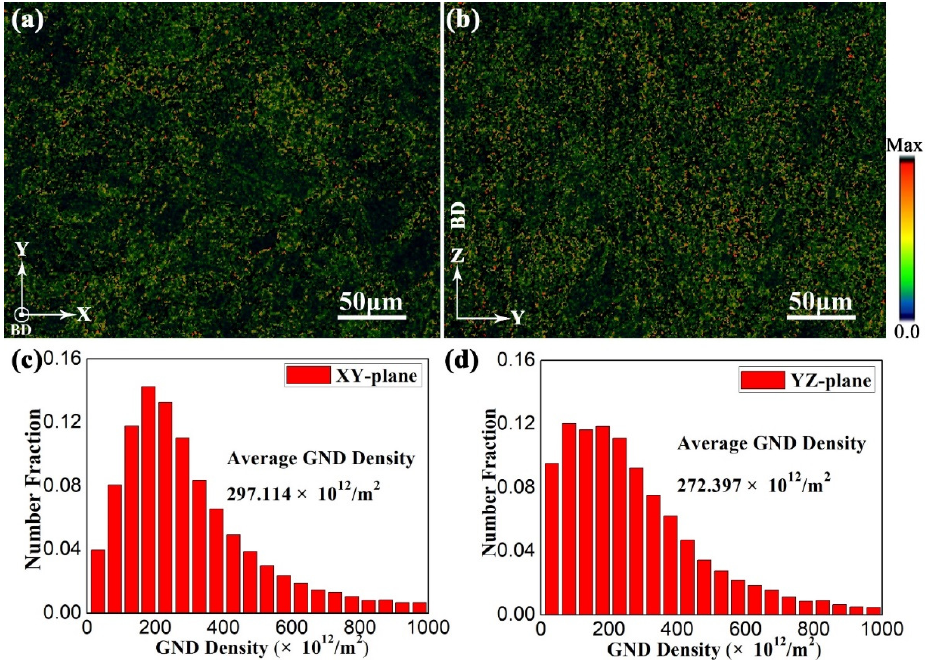
Figure 16. The EBSD maps of the GNDs with the corresponding distributions in sample H-X at ( a , c ) XY-, and ( b , d )